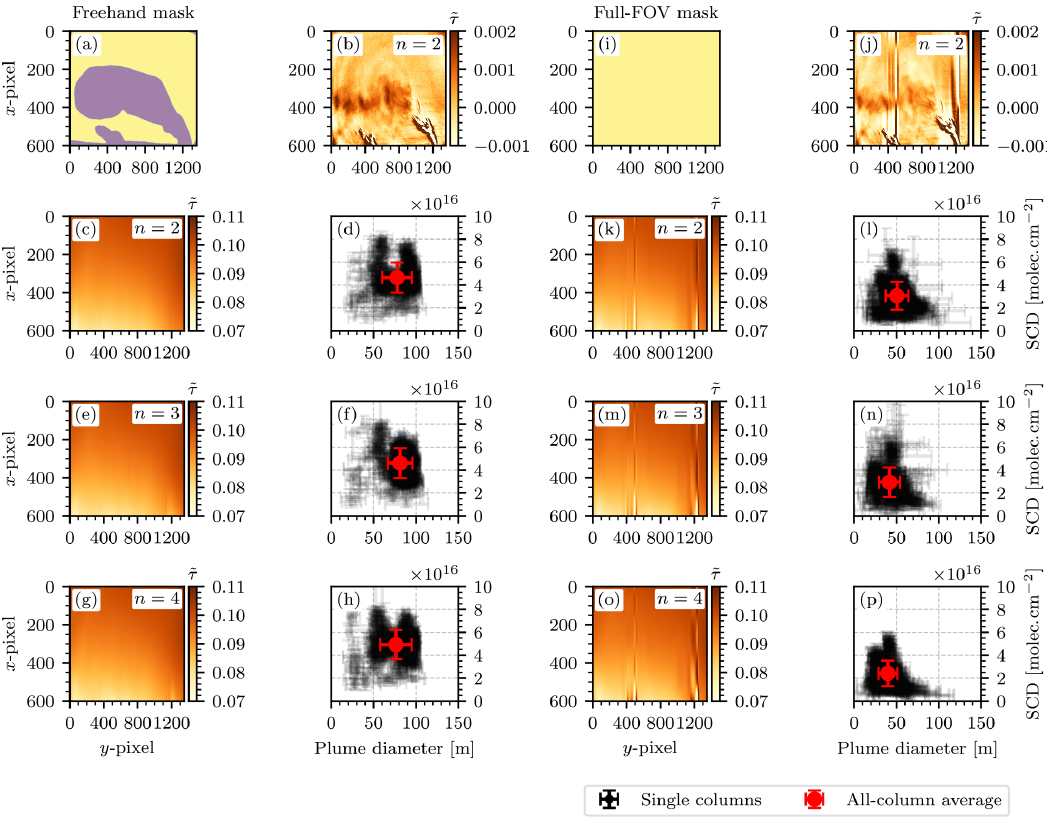
Figure 16. Comparison of the results from different variants of the background fitting procedure as described in Sect. 4.2.1. Panels (a) – (h) show the procedure for the freehand mask used in Sect. 4.2.1, but with different polynomial degrees of up to n = 4. Panels (i) – (p) show the same procedure for a fit mask that covers the entire FOV of the camera images. The results are summarized in Table 2. Table 2. Summary of results from different variants of the background fitting procedure as described in Sect. 4.2.1 and shown in Fig. 16. The full-FOV fit mask yields smaller plume SCDs and diameters than the freehand mask. n = 2, n = 3, and n = 4 yield similar results for both fit masks.